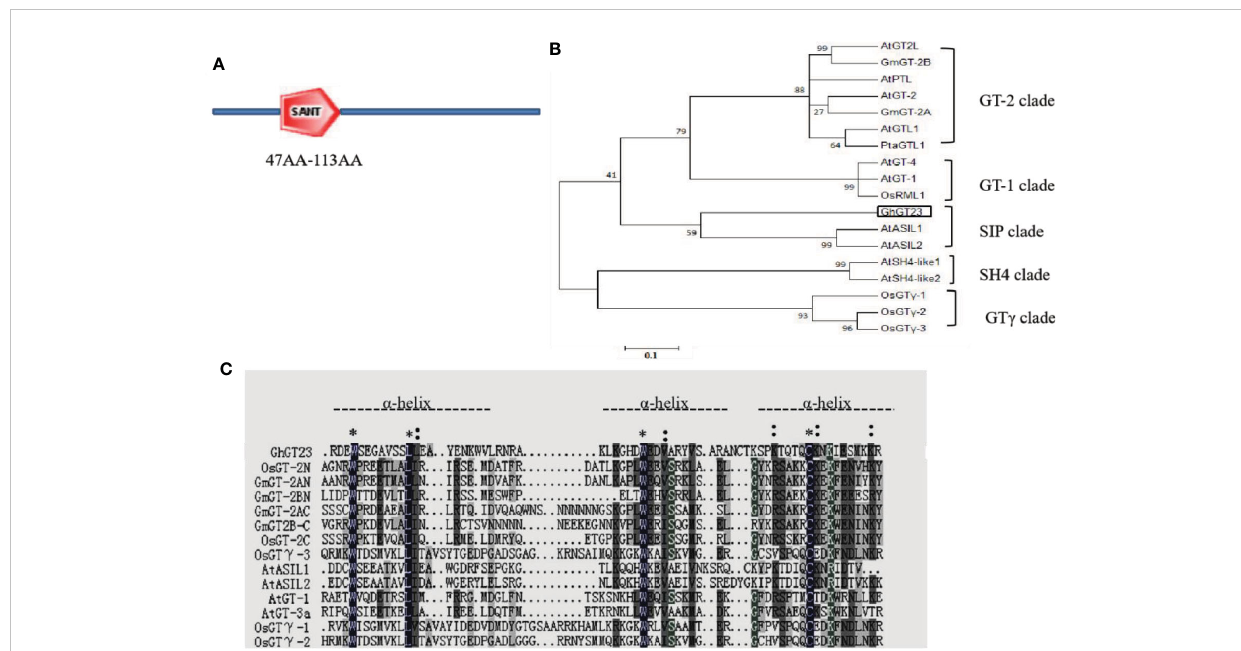
FIGURE 2 Schematic representation, phylogenetic analysis, and amino acid sequence alignment of GhGT23. (A) Schematic diagram of the GhGT23 protein with the SANT domain highlighted between residues 47 and 113. (B) Phylogenetic analysis of GhGT23 with other TTFs. The analysis was performed using MEGA 6.0 with the neighbor joining method and 1000 replicates. Numbers on the fi gure are bootstrap values. The sequences are from rice ( Oryza sativa ), soybean ( Glycine max ), and Arabidopsis ( Arabidopsis thaliana ) plants. GT-1 clade: AtGT-1 (At1g13450), AtGT-4 (At3g25990), OsRML1 (AL627350); GT-2 clade: AtGT-2 (At1g76890), AtGTL1 (At1g33240), AtGT2L (At5g28300), AtPTL (At5g03680), GmGT-2A (EF221753), GmGT-2B (EF221754), PtaGTL1 (JN113092); SH4 clade: AtSH4-like1 (At2g35640), AtSH4-like2 (At1g31310); GT clade: OsGT-1 (Os02g33770), OsGT-2 (Os11g06410), OsGT-3 (Os12g06640); and SIP clade: AtASIL1 (At1g54060), AtASIL2(At3g14180), GhGT23. (C) Multiple sequence alignment of the SANT domain from the TTFs in (B) . * indicates a completely conserved amino acid residue; indicates a partially conserved amino acid. The dotted line denotes helices in the trihelix DNA-binding